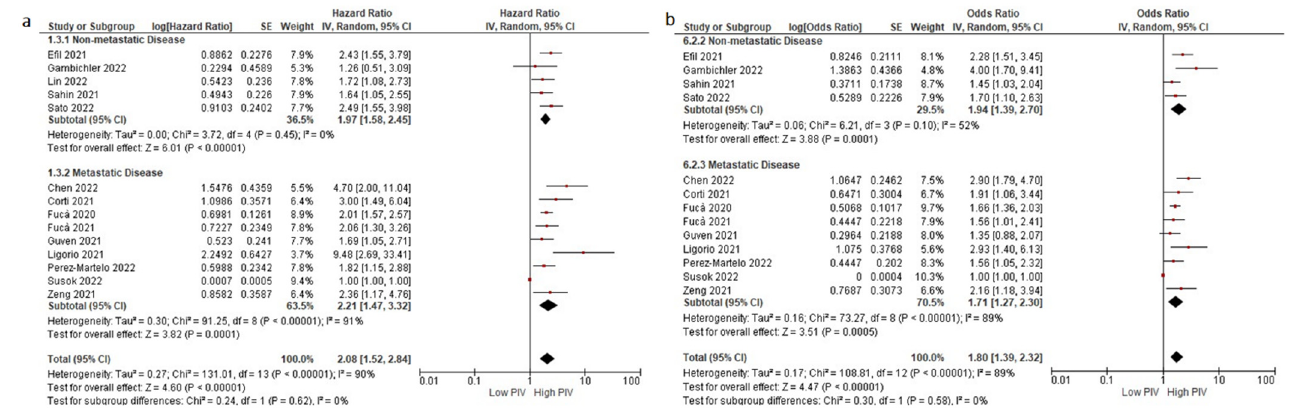
) indicate (cid:35)